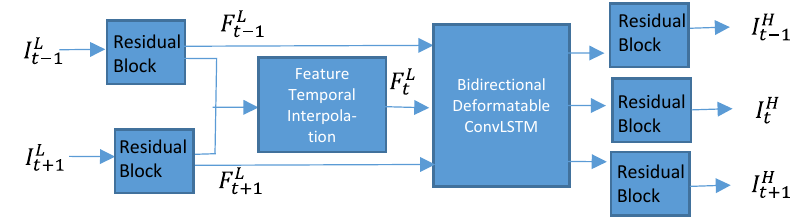
Figure 3. Comparison of no frame selection vs. frame selection for CLEAR algorithm. ( a ) No frame selection; ( b ) with frame